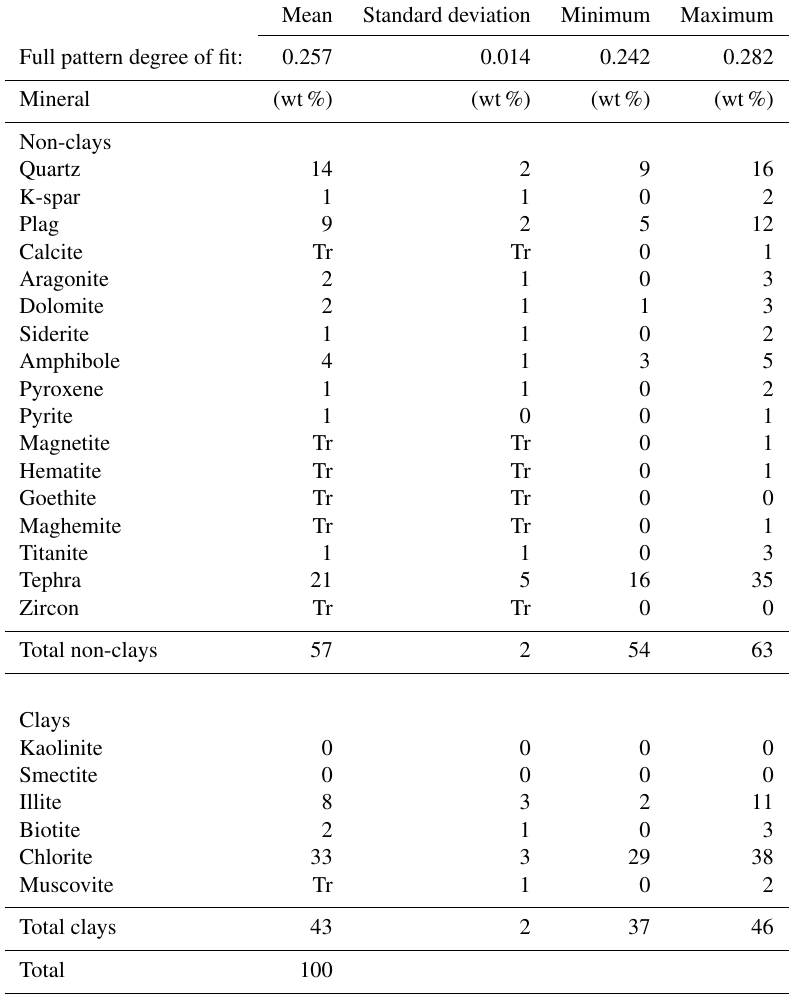
Table 5. Summary statistics for X-ray